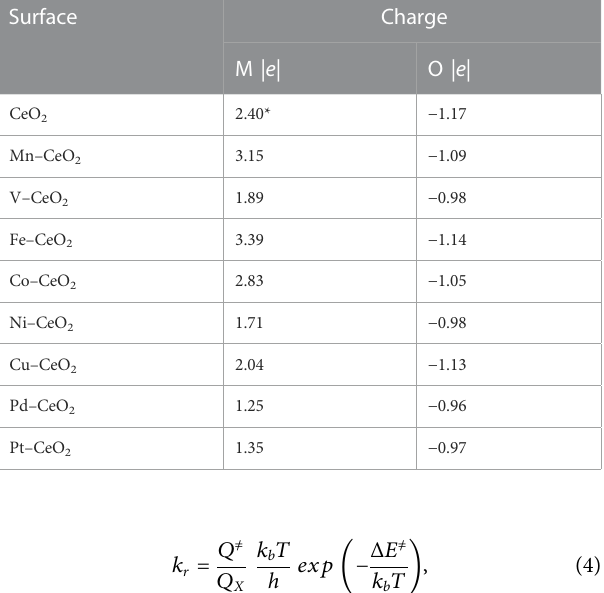
TABLE 1 Bader charge analysis of CeO 2 and doped CeO 2 surfaces. The * sign indicates the charge on the Ce atom in pristine CeO 2 .